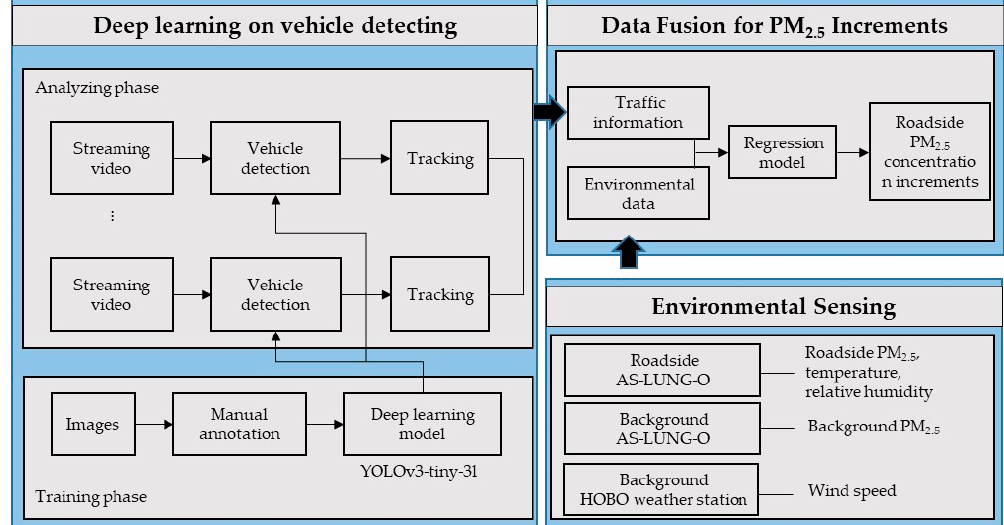
Figure 1. The system flowchart of the data flow from both vehicle-detecting and PM 2.5 sensing to data fusion for PM 2.5 increments.